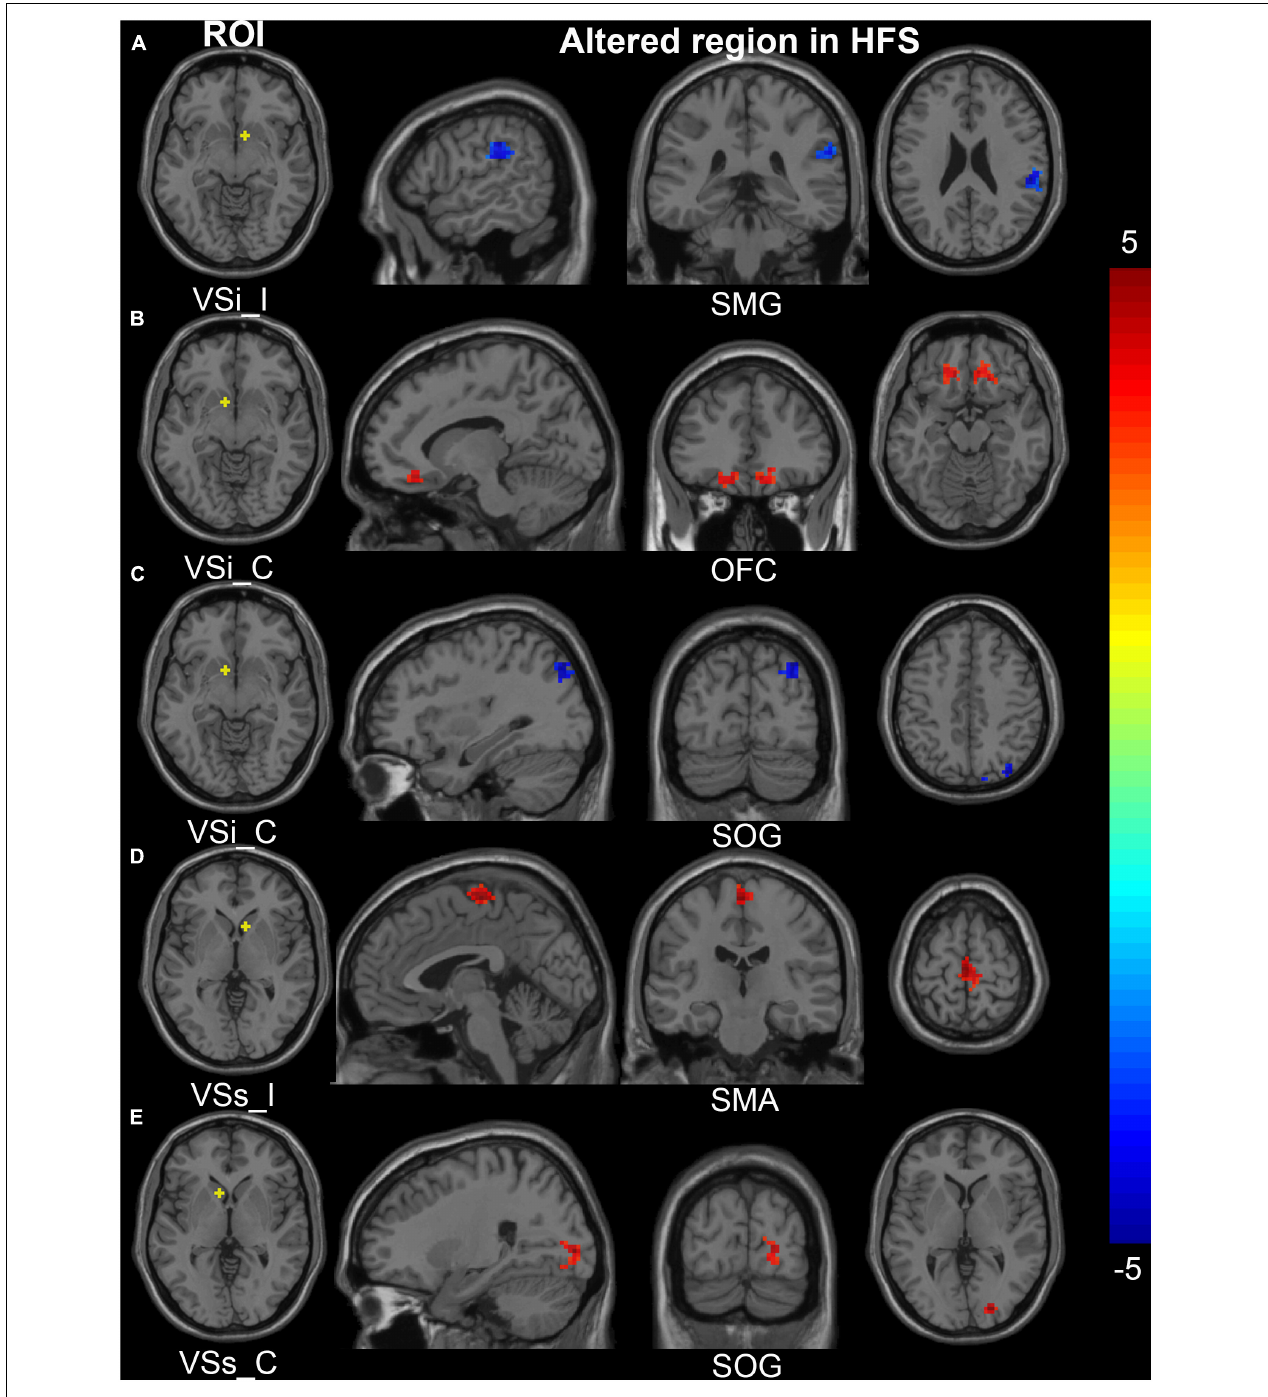
FIGURE 5 | Altered FC in the cortical-striatal network (inferior and superior ventral striatum ROIs). In the HFS group compared with the HC group: (A) The FC between ipsilateral VSi and ipsilateral SMG was decreased. (B) The FC between contralateral VSi and bilateral OFC was increased. (C) The FC between contralateral VSi and ipsilateral SOG was decreased. (D) The FC between ipsilateral VSs and bilateral SMA was increased. (E) The FC between contralateral VSs and ipsilateral SOG was increased. The color bar represents the t value. FC, functional connectivity; ROIs, regions of interest; HFS, hemifacial spasm; HC, healthy control; I, ipsilateral; C, contralateral; VSi, inferior ventral striatum; VSs, superior ventral striatum; SMG, supramarginal gyrus; OFC, orbitofrontal cortex; SOG, superior occipital gyrus; SMA, supplementary motor area.